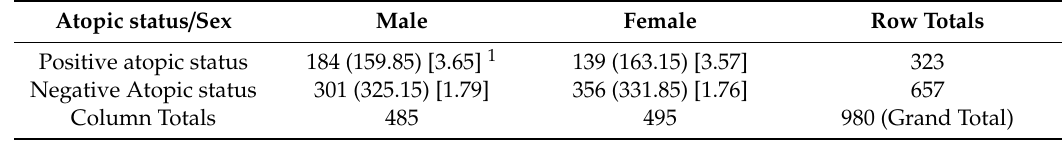
Table 5. Atopic status in athletes with and without EIB.